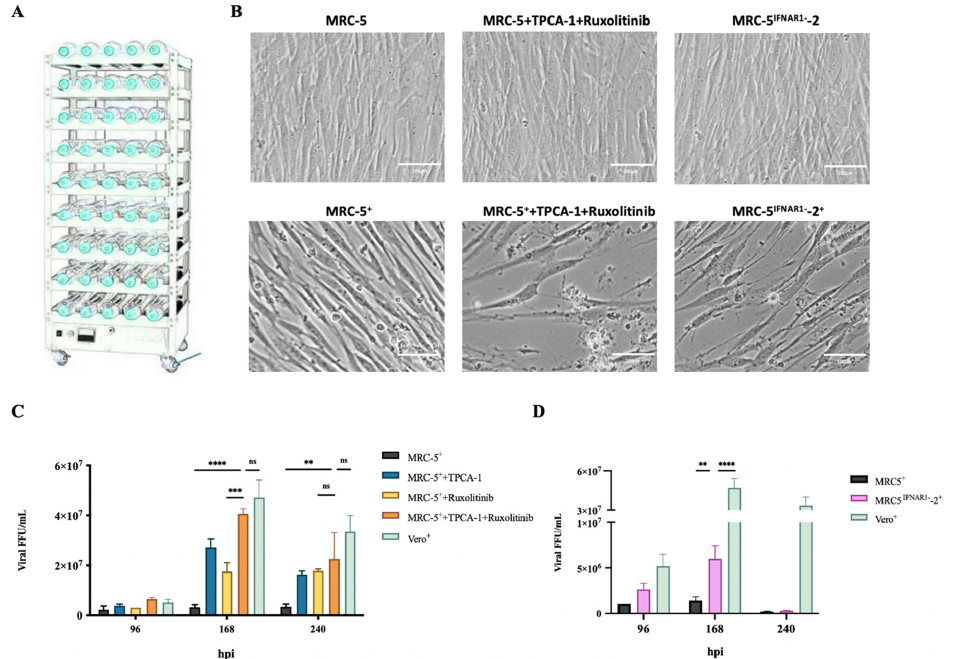
Figure 5. The IFN inhibitor or MRC-5 IFNAR1 − cell lines enhanced rabies virus (RABV) production in pilot-scale experiments. ( A ) The pilot production platform consists of 30 spinner flasks with a surface area of 1500cm 2 and a constant temperature flask-rotating machine. The MRC-5 IFNAR1 − cells and MRC-5 cells treated with both 2 μ M TPCA-1 and Ruxolitinib 2 h before RABV infection were infected with the PM RABV strains at an MOI of 0.05 in 1500 square centimeter spinner flasks, respectively. Vero cells were infected with the aG RABV strains at a MOI of 0.001. ( B ) Representative cell status was recorded at 168 hpi. ( C ) The MRC-5 cells were treated with 4 μ M TPCA-1, 4 μ M Ruxolitinib, or both 2 μ M TPCA-1 and Ruxolitinib 2 h before RABV infection. Viral titers in the culture supernatant were detected by focus-forming unit (FFU) assays at 96, 168, and 240 hpi. ( D ) The MRC-5 or MRC-5 IFNAR1 − cells were infected with RABV. Viral titers in the culture supernatant were detected by FFU assays at 96, 168, and 240 hpi. + : RABV infection; ** p < 0.01; *** p < 0.001; **** p < 0.0001; ns p ≥ 0.05.